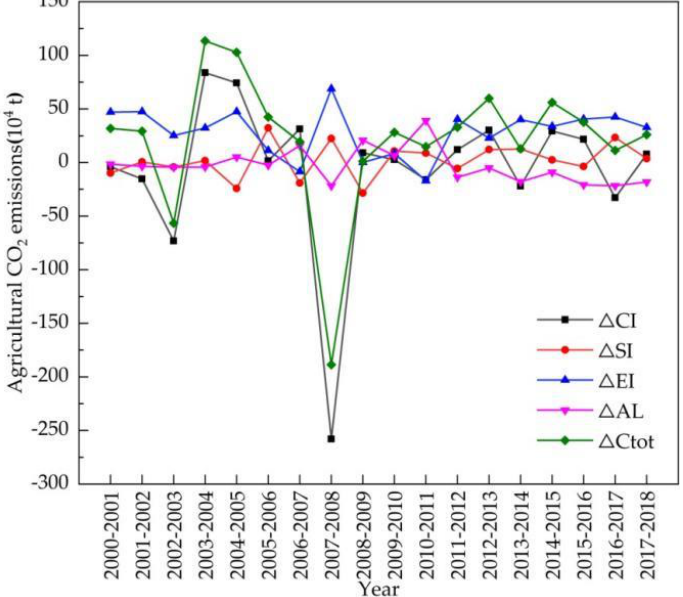
Figure 7. Characteristics of four factors’ contribution to the variation in agricultural CO 2 emissions in Jilin province during 2000–2018.